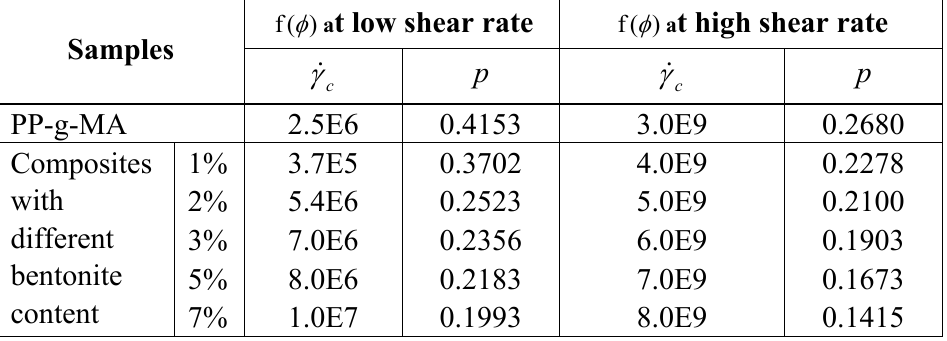
p )/( γγ && = for PP/organobentonite Table 2. The parameter values in p cc